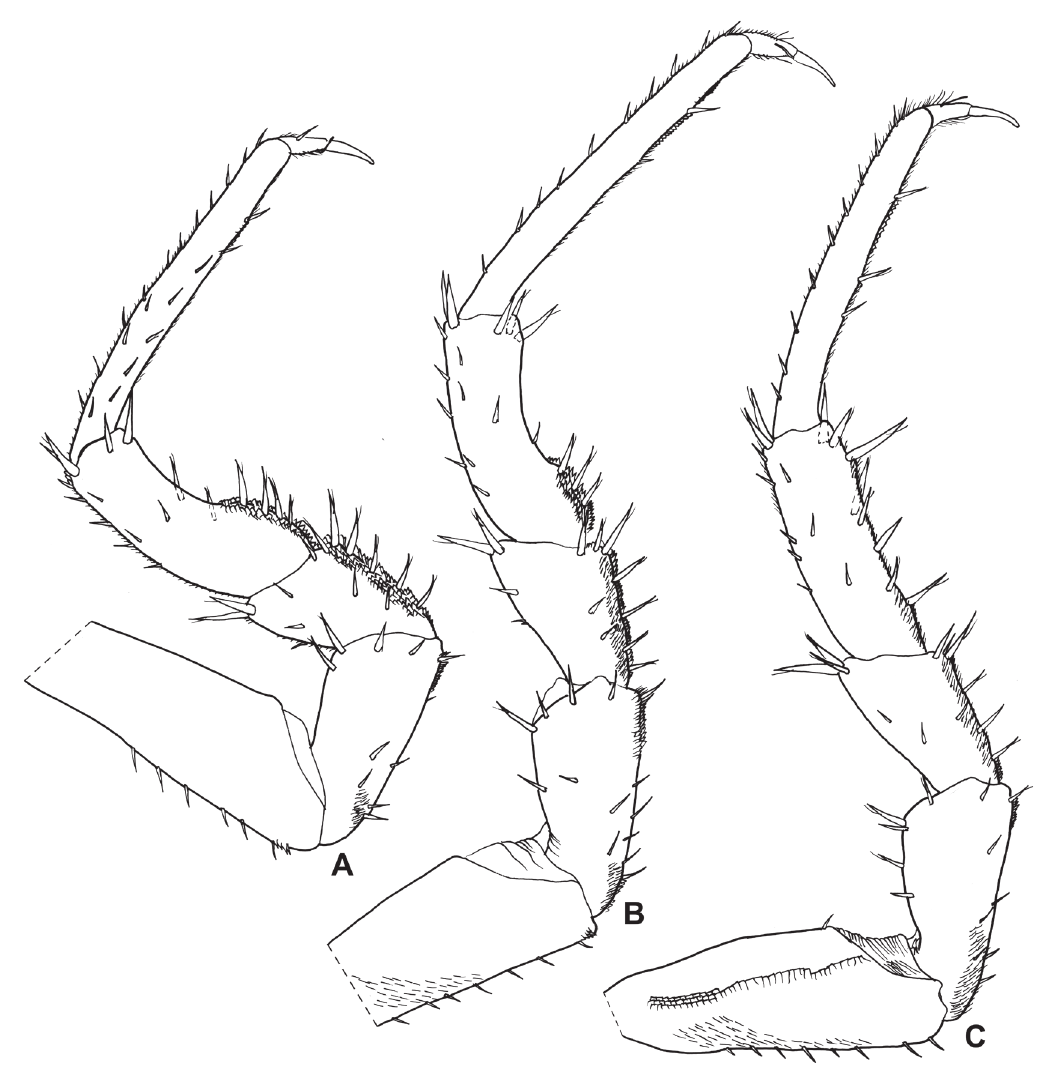
Figure 5. Xangoniscus odara n. sp. (male paratype). A, pereopod 5; B, pereopod 6; C, pereopod